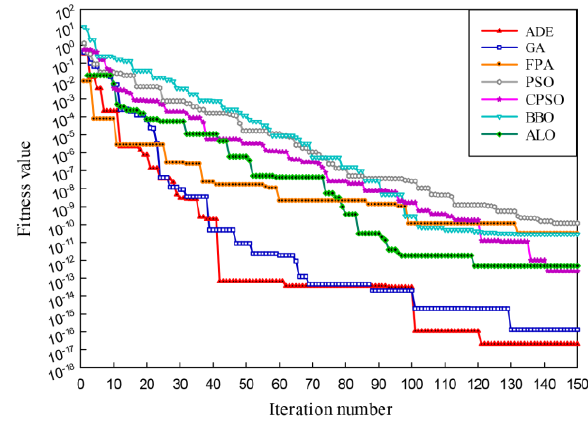
Figure 13. Convergence curves of different heuristic algorithms.